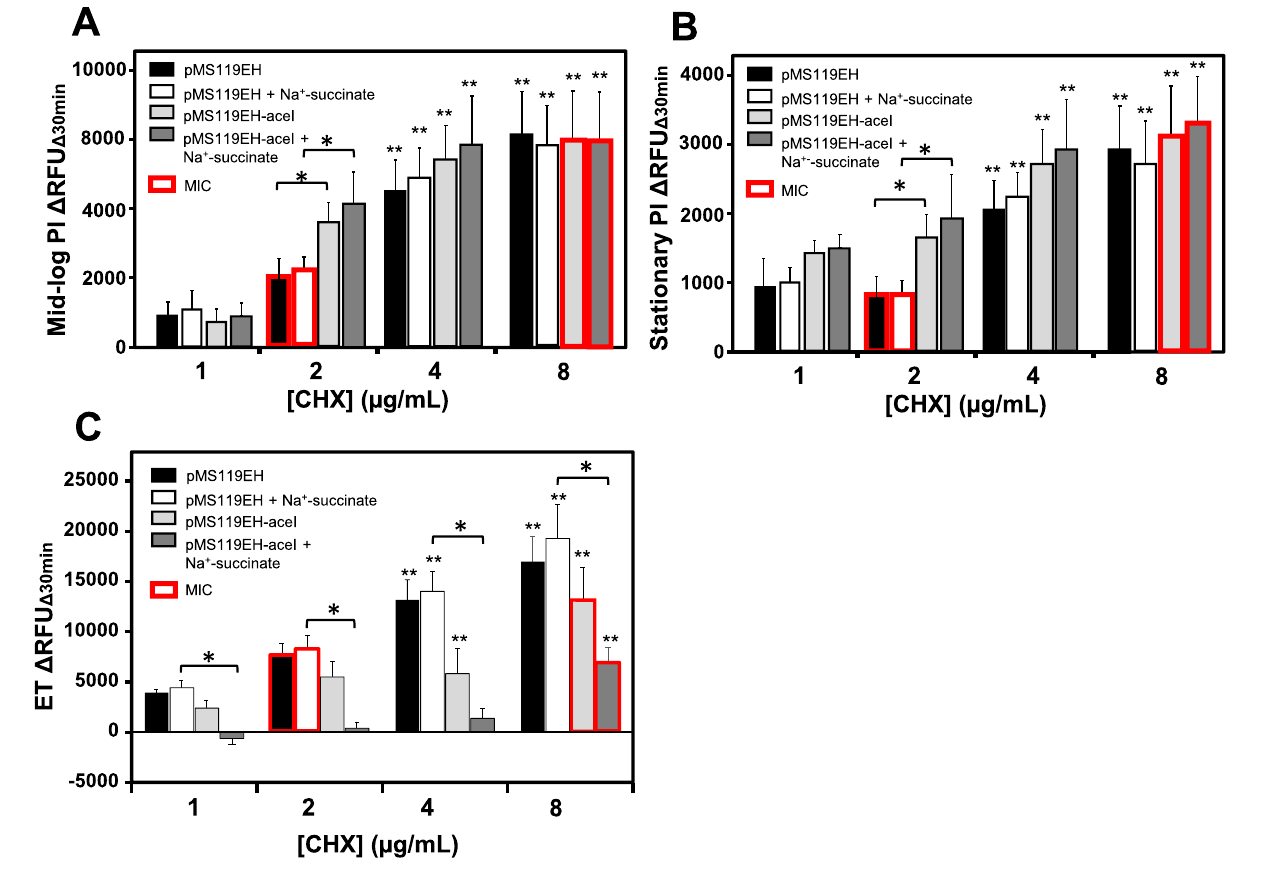
Figure 2. RFDMIA of E. coli K-12 BW25113 pMS119EH and pMS11EH- aceI transformants measured at mid-log or stationary phase with and without Na + -succinate and RFDMIA replacing PI with ET. ( A ) RFDMIA mean PI DRFU D30min values of WT pMS119EH and pMS11EH- aceI transformants harvested at mid-log phase (OD 600nm = 0.5) at increasing CHX concentrations with and without 5 mM Na + -succinate addition. ( B ) RFDMIA mean PI ΔRFU Δ30min values of WT pMS119EH and pMS11EH-aceI transformants harvested at stationary phase (OD 600nm = 1.1–1.5) at increasing CHX concentrations (1–8 µg/mL CHX) with and without 5 mM Na + - succinate. ( C ) RFDMIA mean ET ΔRFU Δ30min values of WT pMS119EH and pMS11EH- aceI transformants harvested at stationary phase (OD 600nm = 1.1–1.5) at increasing CHX concentrations (1–8 µg/mL CHX) with and without 5 mM Na + -succinate. Mann–Whitney U tests were used to identify the lowest CHX concentration with a significant increase in ΔRFU Δ30min value (**) for the same sample with P -values ( P < 0.05). This statistical test was also used to determine P < 0.05 for significantly different ΔRFU Δ30min value comparisons between the control and the measured sample at the same CHX concentration denoted as horizontal lines with an asterisks (*). In all panels, bar plots represent at minimum of three bacterial bioreplicate cell suspensions measured from three technical replicate samples (n =